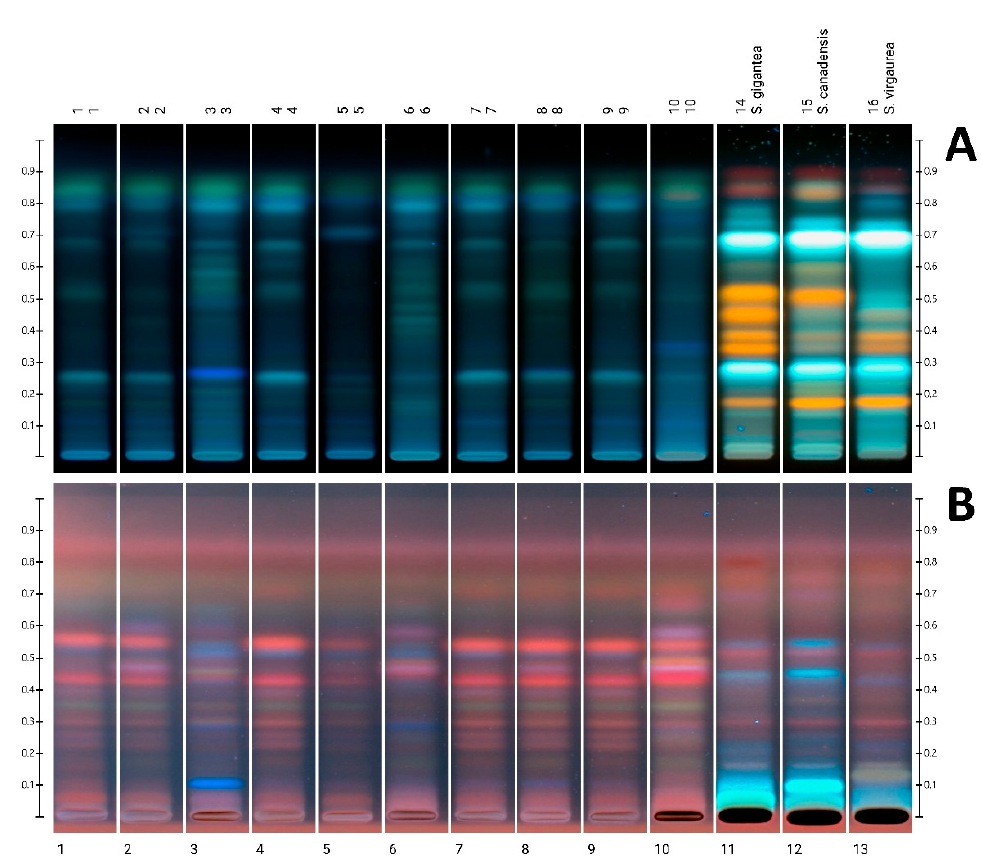
Figure 4. HPTLC plates images: ( A )—developed with eluent system A, derivatized with NP/PEG reagent, ( B )—developed with eluent system B, derivatized with p -anisaldehyde reagent, Track 1–10: goldenrod honey, track 11: S. gigantea , track 12: S. canadensis , track 13: S. virgaurea.